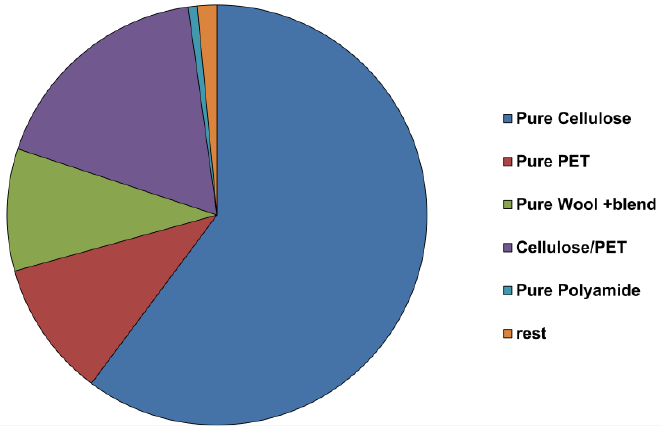
Figure 1. Composition of the mixed textile waste used in the present study. Data were kindly provided by the SOEX Group (Hamburg, Germany).